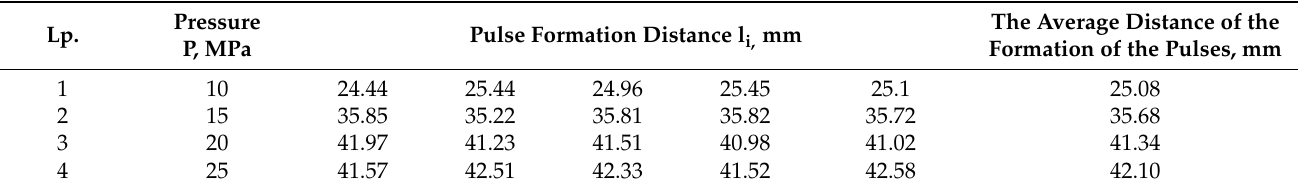
Figure 13. Sample images of a pulsating water stream flowing from the outlet nozzle, tested under air conditions, working at the nominal pressure: ( a ) 10 MPa, ( b ) 25 MPa. Measurements of the shape of the hydrodynamic pulses were made with the use of Auto-CAD software, which enabled scaling of the photos in relation to the characteristic dimension, i.e., the diameter of the outlet nozzle. Examples of such measurements are presented in Figure 13 and the results are summarized in Table 6. Table 6. Selected dimensional parameters of the selected model of a self-excited pulsation head intended for drilling holes with a water jet for pressures from 15 MPa to 150 MPa.